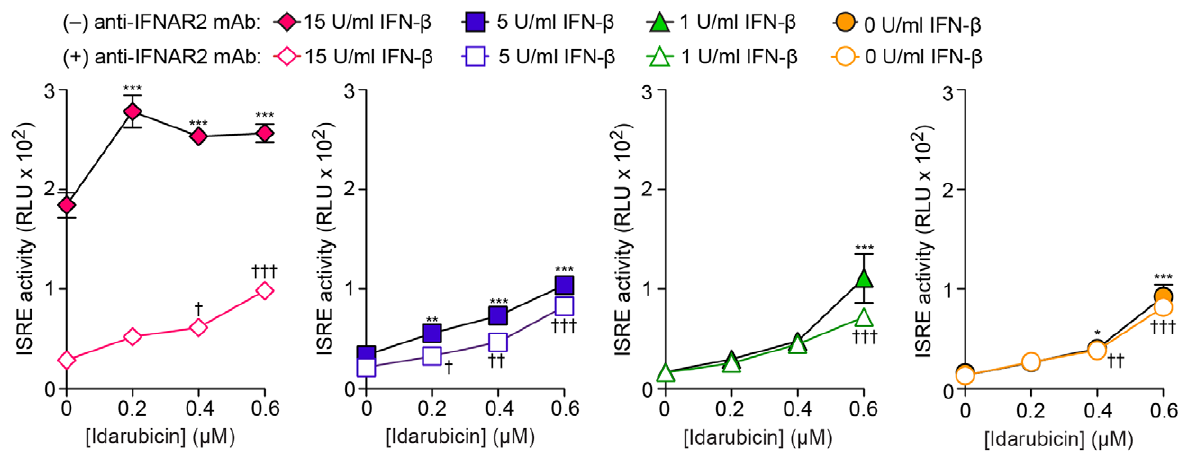
Figure 6. Effect of IFN-receptor blockade on idarubicin stimulation of ISRE activity. Idarubicin concentration-response for ISRE activity without and with treatment with IFN- b (1, 5, and15 U/ml) in the absence or presence of anti-IFNAR2 blocking mAb. *, { =p , 0.05 ; **, {{ =p , 0.01; ***, {{{ =p , 0.001. p-values for individual comparisons are from Bonferroni post-tests from repeated measures two-way ANOVA, comparing the 0 nM Idarubicin condition to the other drug doses. For 15 U/ml IFN- b , overall significance: anti-IFNARII, p , 0.0001, IDA dose, p , 0.0001; interaction, p=0.0023. For 5 U/ml IFN- b , overall significance: anti-IFNARII, p , 0.0001, IDA dose, p , 0.0001; interaction, p=0.3294. For 1 U/ml IFN- b , overall significance: anti-IFNARII, p , 0.0892, IDA dose, p , 0.0001; interaction, p=0.1542. For 0 U/ml IFN- b , overall significance: anti-IFNARII, p , 0.4432, IDA